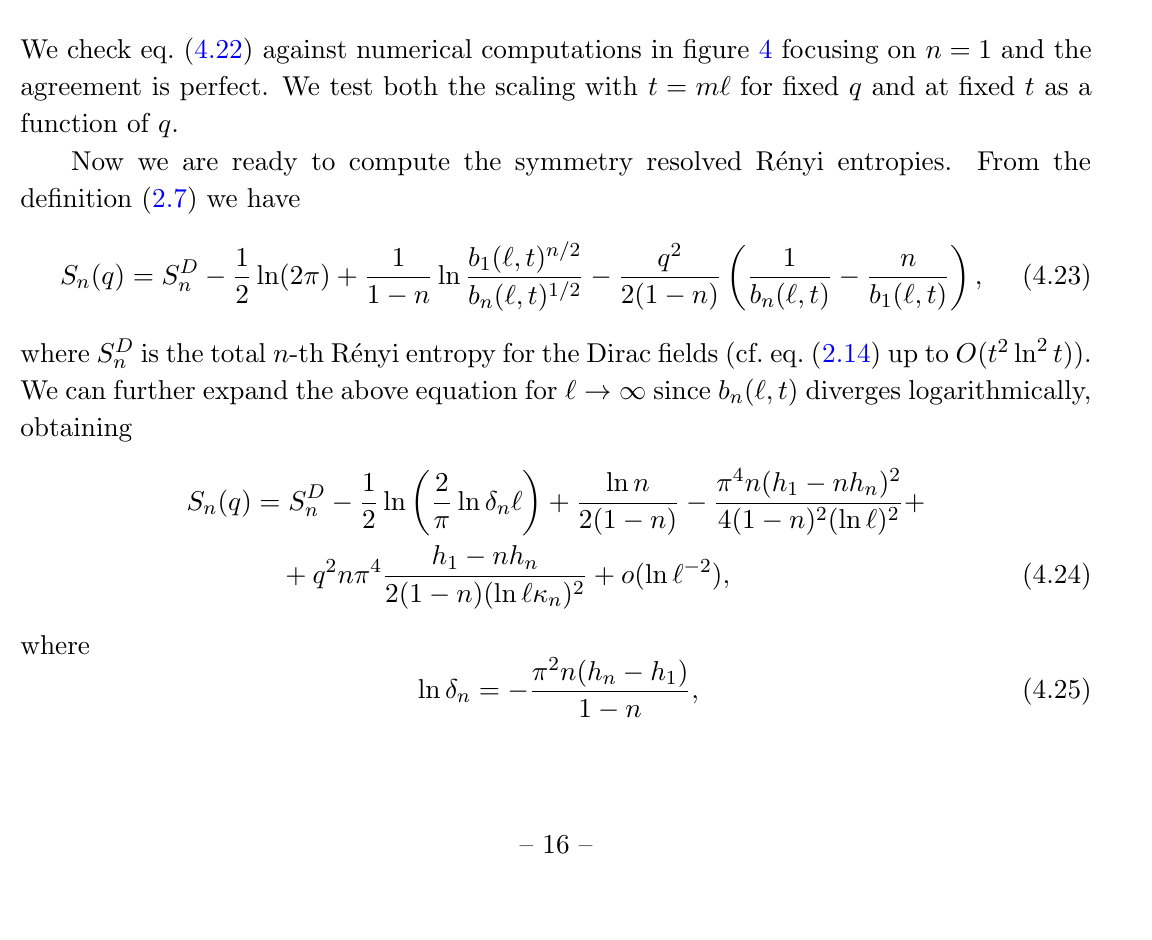
Figure 4 . The probability Z 1 ( q ). Top: as a function of t = m‘ at (cid:12)xed q = 0 for mass m = 0 : 0005 (left) and m = 0 : 001 (right). The dashed green line is Z 1 ( q ) obtained by the saddle point approximation, i.e. eq. (4.22). The solid green line is the exact Fourier transform without taking the quadratic approximation. For large ‘ (and t as a consequence) the saddle-point approximation converges to the exact value, as expected. Bottom: the same at (cid:12)xed t as function of q